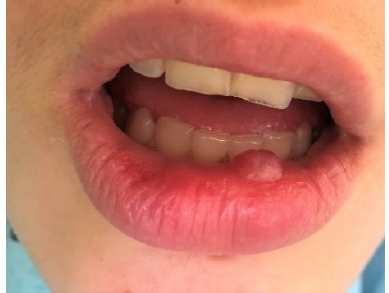
Figure 4. Mucocele on the lower lip of an adolescent girl. Typical dome-shaped fluctuant mucosal swelling. The lower lip is the most common site for this lesion to develop due to the relative ease of traumatizing this area.